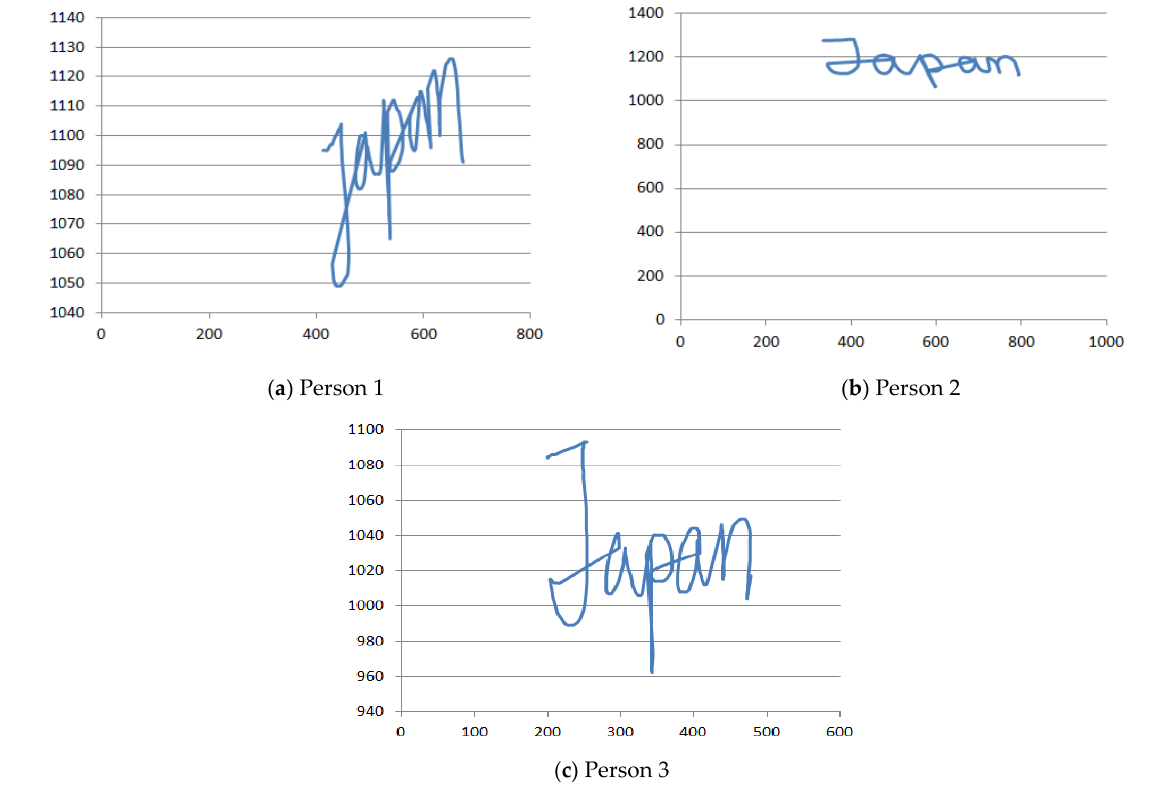
Figure 3. Writing graph with the x -axis, y -axis values for different persons for the same keyword: ( a ) Person 1 ( b ) Person 2 ( c ) Person 3.